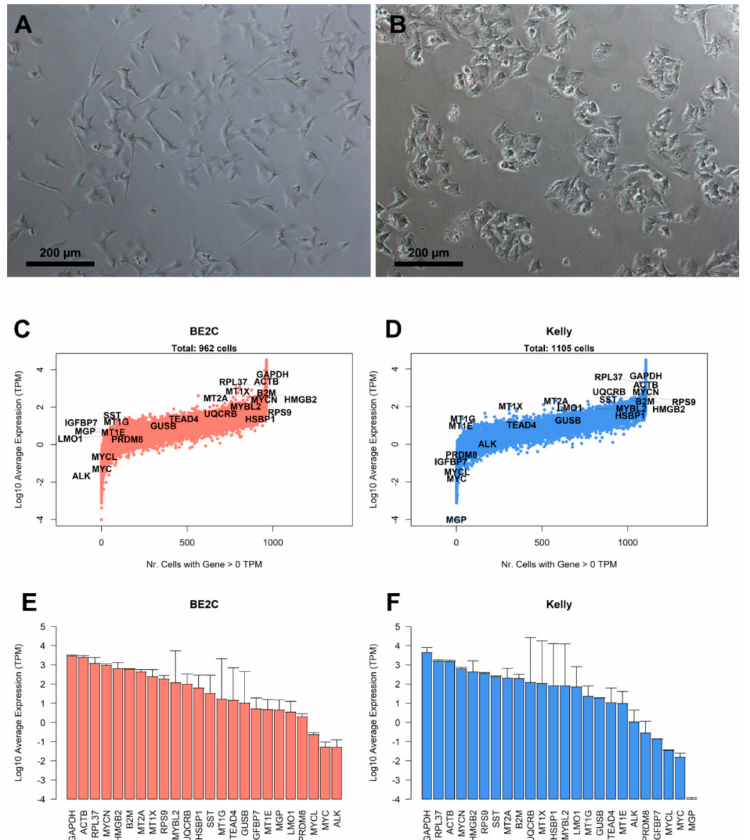
Figure 1. Initial analysis of single-cell expression on Kelly and BE2C cell lines. ( A ) BE2C and ( B ) Kelly cells prior to library preparation sequencing. ( C , D ) Plot showing the Log10 TPM average expression for all genes in the dataset ( y -axis) and the number of cells where the gene is detected ( x -axis) with TPM > 0 (i.e., more than one read) in BE2C and Kelly cells. ( E , F ) Selected representative genes shown as bar plots of overall log10 TPM average expression, with error bars depicting standard deviation in the dataset for BE2C and Kelly cells. A pseudovalue of 0.0001 (10 − 4 ) is added to TPM values (also in the next figures) prior to calculation of